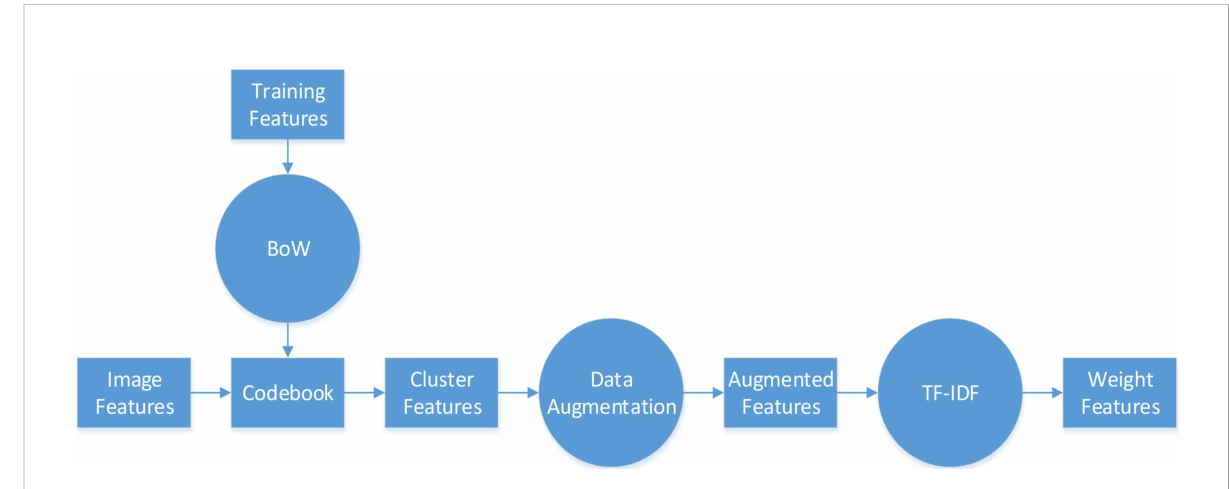
FIGURE 3 BoW and TF – IDF